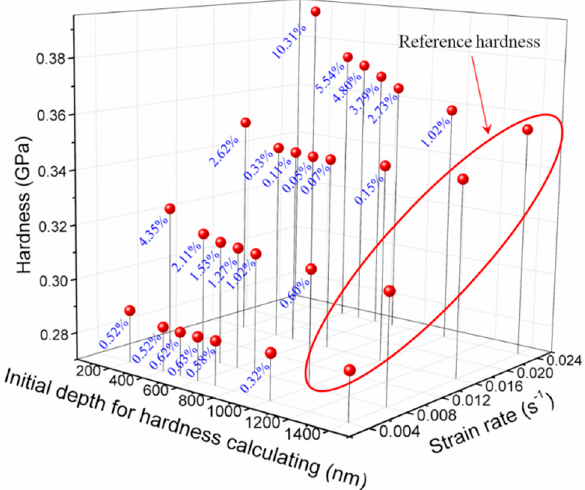
Figure 12. Three-dimensional plots of the relationship of hardness against strain rate and depth range. Table 3. Average modulus and hardness values calculated from different depth ranges under four strain rates.